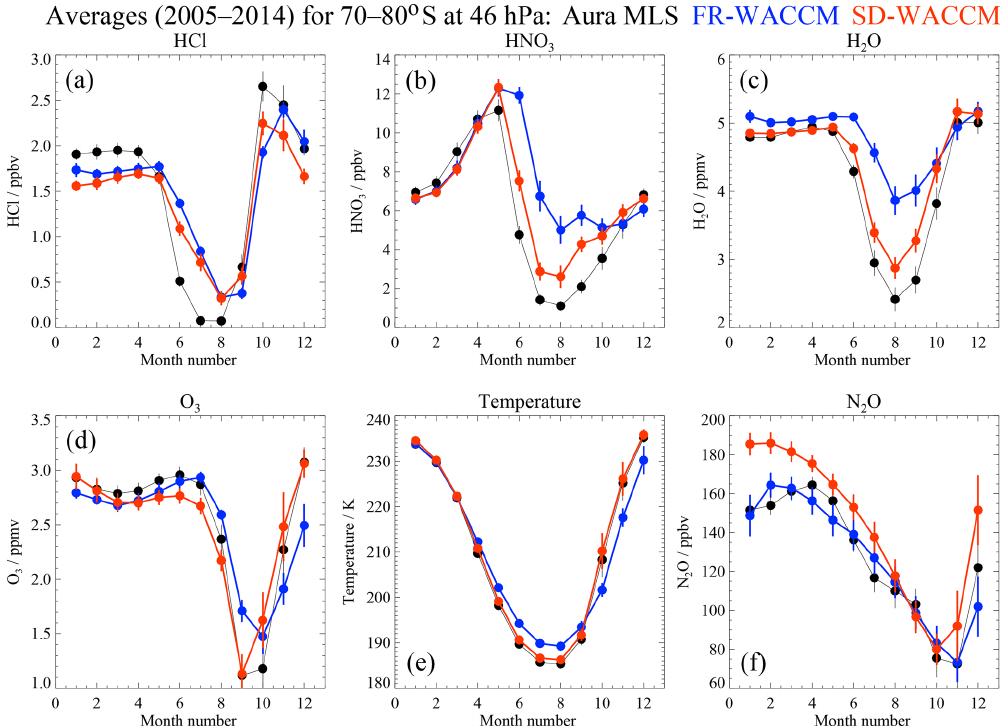
Figure 7. Each of the panels shows average seasonal changes from 2005 to 2014 for the 70–80 ◦ S region at 46hPa. Data values (black) are from Aura MLS and model comparisons (FR-WACCM in blue, SD-WACCM in red) are provided for HCl (a) , HNO 3 (b) , H 2 O (c) , O 3 (d) , temperature (e) , and N 2 O (f) . For each month, the error bars represent twice the standard errors in the means, based on the set of 10-monthly averages (from 2005 through